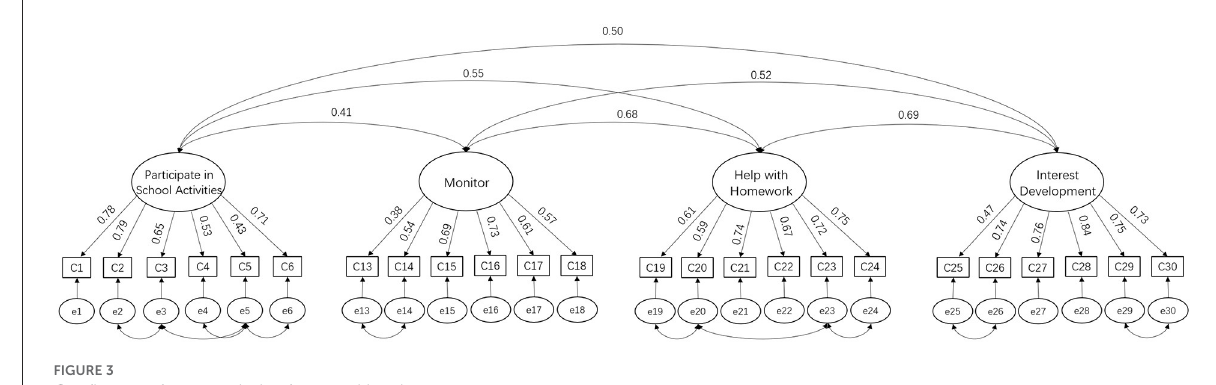
FIGURE3 Confimatory factor analysis of parental